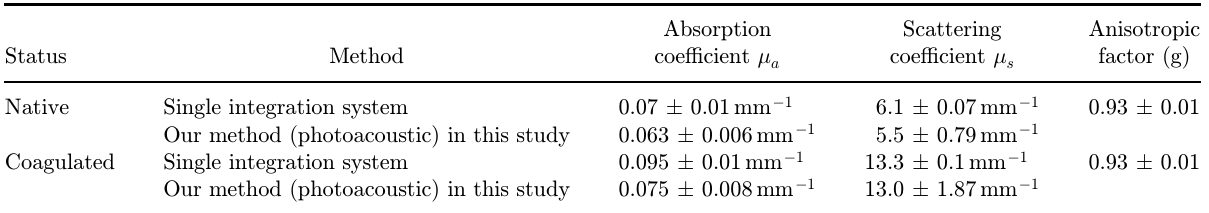
Table 3. Comparison of the optical properties of liver determined by method in this study with single integration